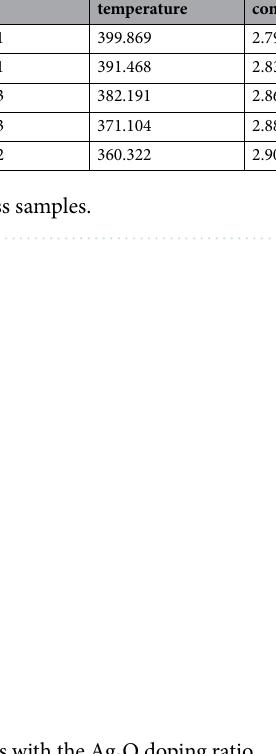
Figure 10. Variation of the micro-hardness of the fabricated glasses with the Ag 2 O doping